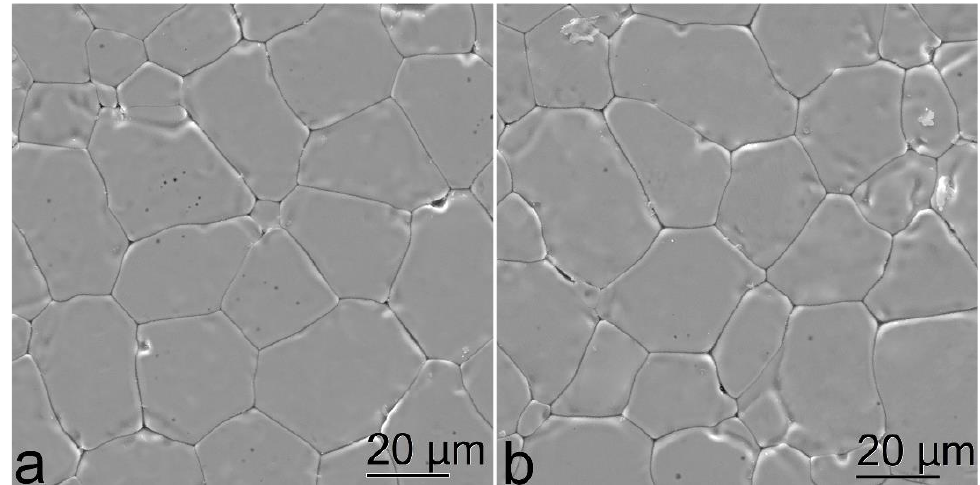
Figure 4. Microstructure images of the (ZrO 2 ) 0.909 (Y 2 O 3 ) 0.09 (Eu 2 O 3 ) 0.001 ceramic specimens synthesized using different methods from crushed single crystals: ( a ) uniaxial compaction; ( b ) slip casting.